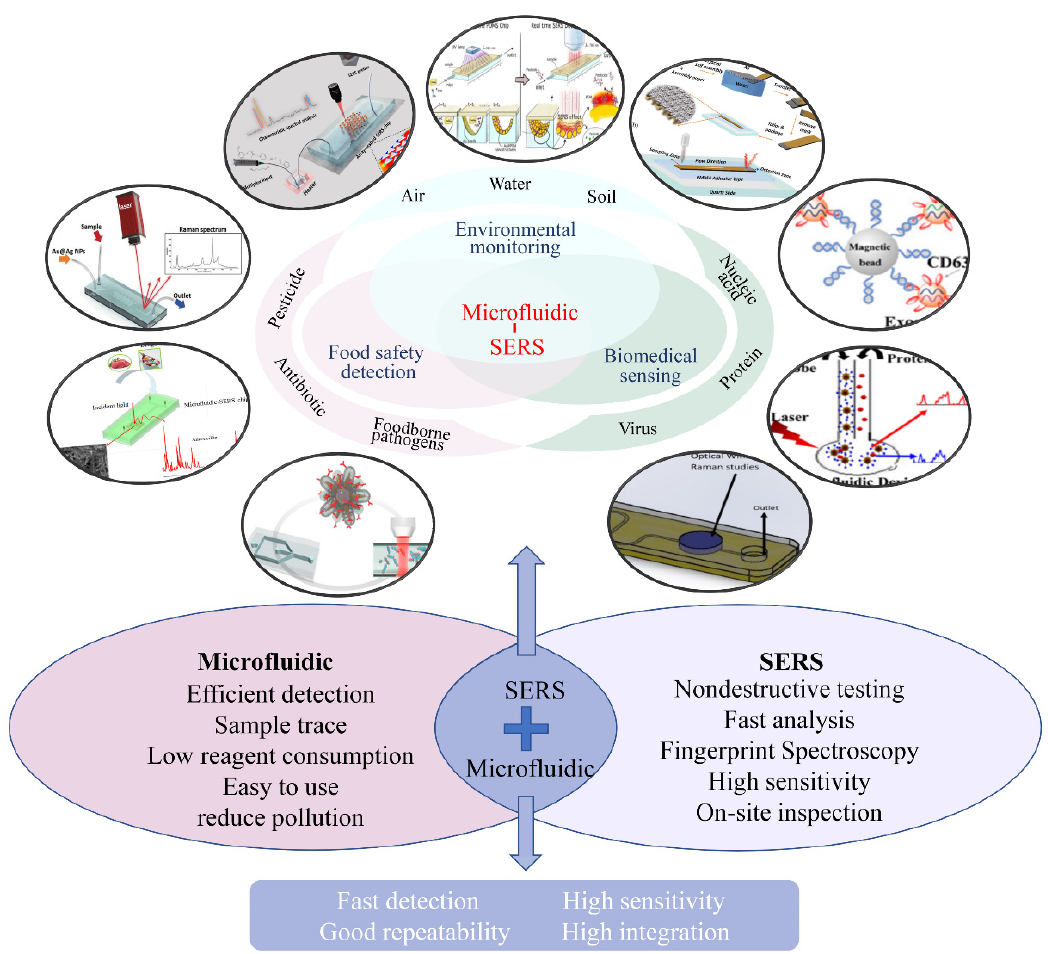
Figure 6. Application prospect of the microfluidic-SERS detection system. Microfluidic-SERS detection systems have broad applications in biomedical sensing, environmental monitoring, and food safety testing. In biomedical sensing, the detection of nucleic acid, protein (adapted with permission from [126]. Copyright {2015} American Chemical Society), virus, and other clinical samples can be realized. In environmental monitoring, pollutants in water (adapted with permission from